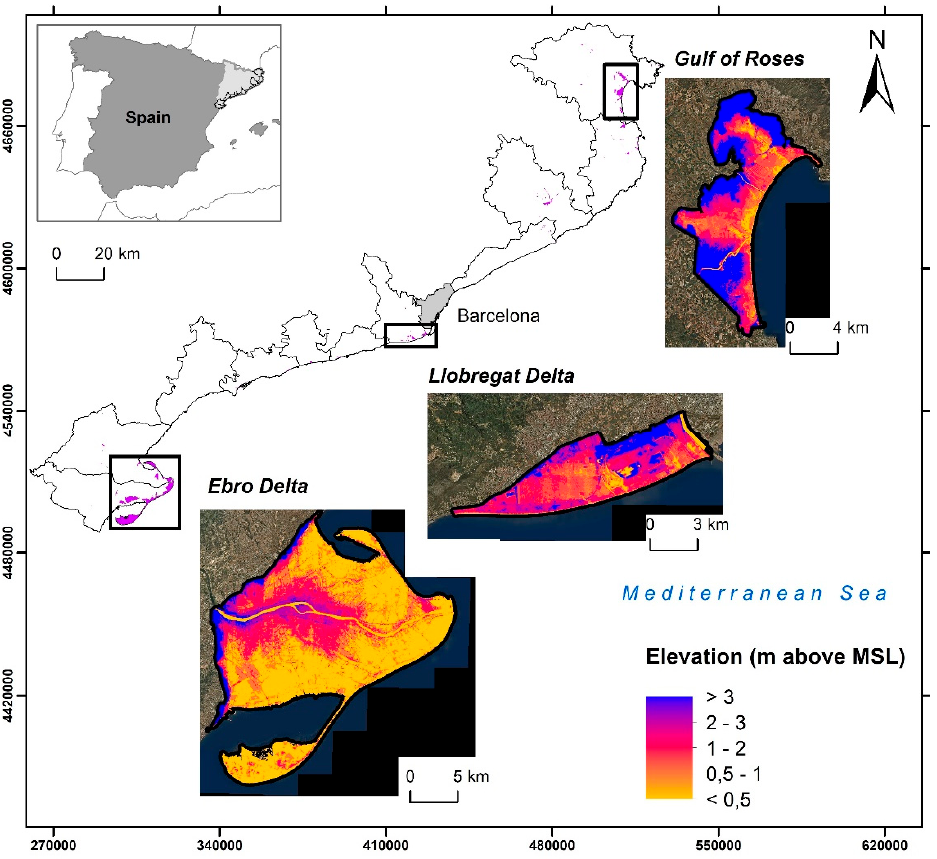
Figure 1. The Catalan coast, coastal comarcas and wetlands (shadowed purple areas). The insets are the low-lying study areas and their digital elevation models (see Table 1). (The geographic coordinate system is ETRS89/UTM zone 31N).